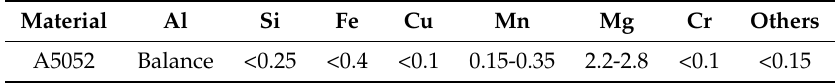
Table 1. Chemical composition of A5052 (mass percentage) specified by American Society for Testing and Materials (ASTM)